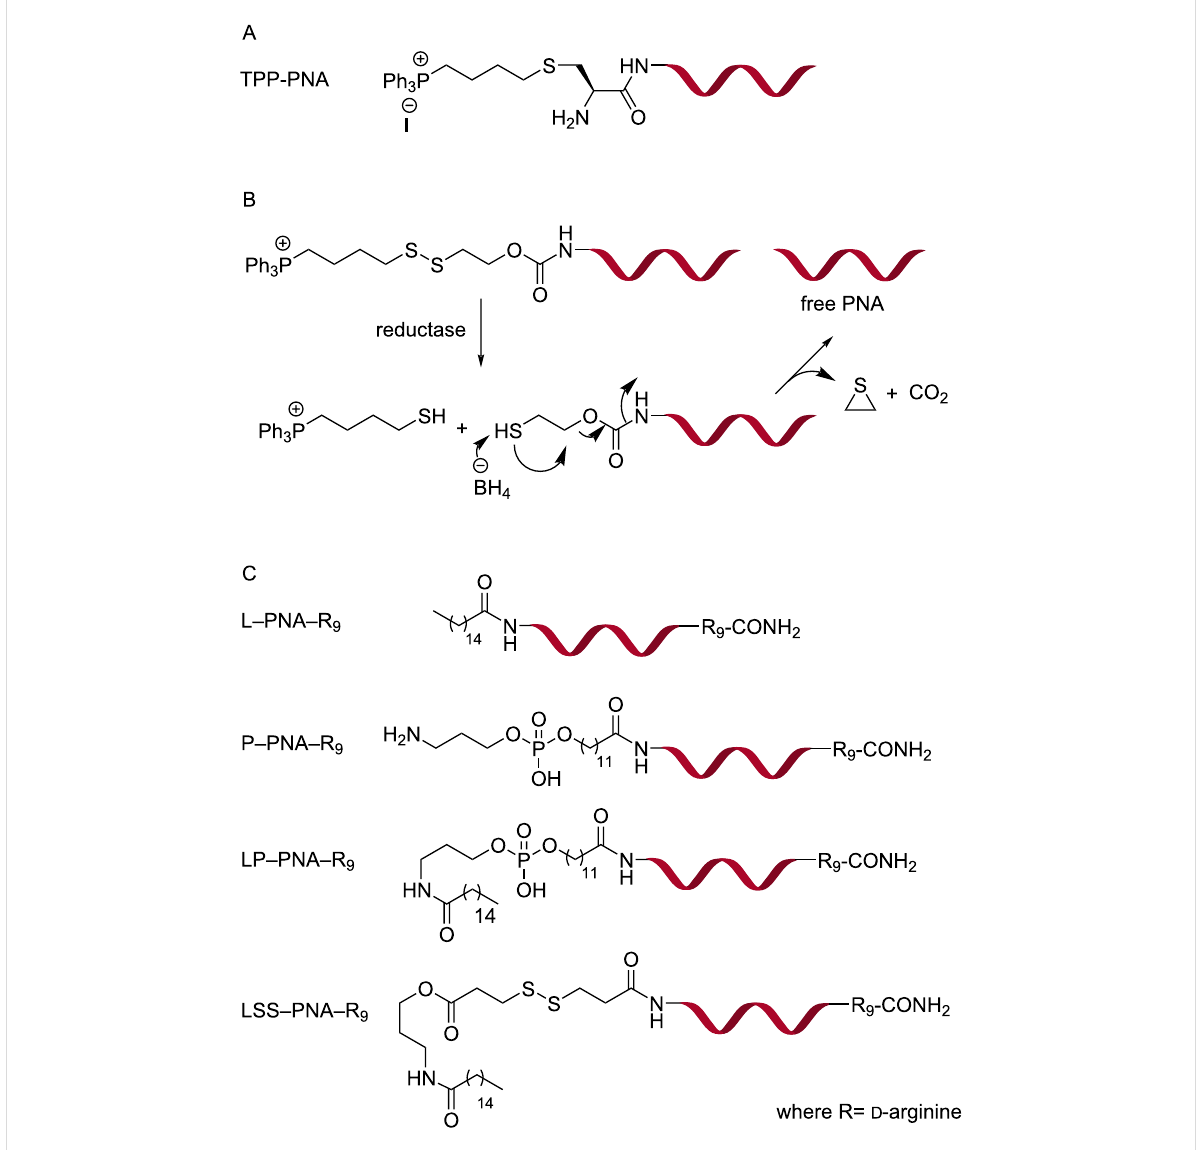
Figure 16: Structures of PNA conjugates with a lipophilic triphenylphosphonium cation (TPP–PNA) through (A) thioether and (B) cleavable disulfide linkage; (C) PNA–R 9 conjugates with lipids, phospholipids and cleavable lipids.